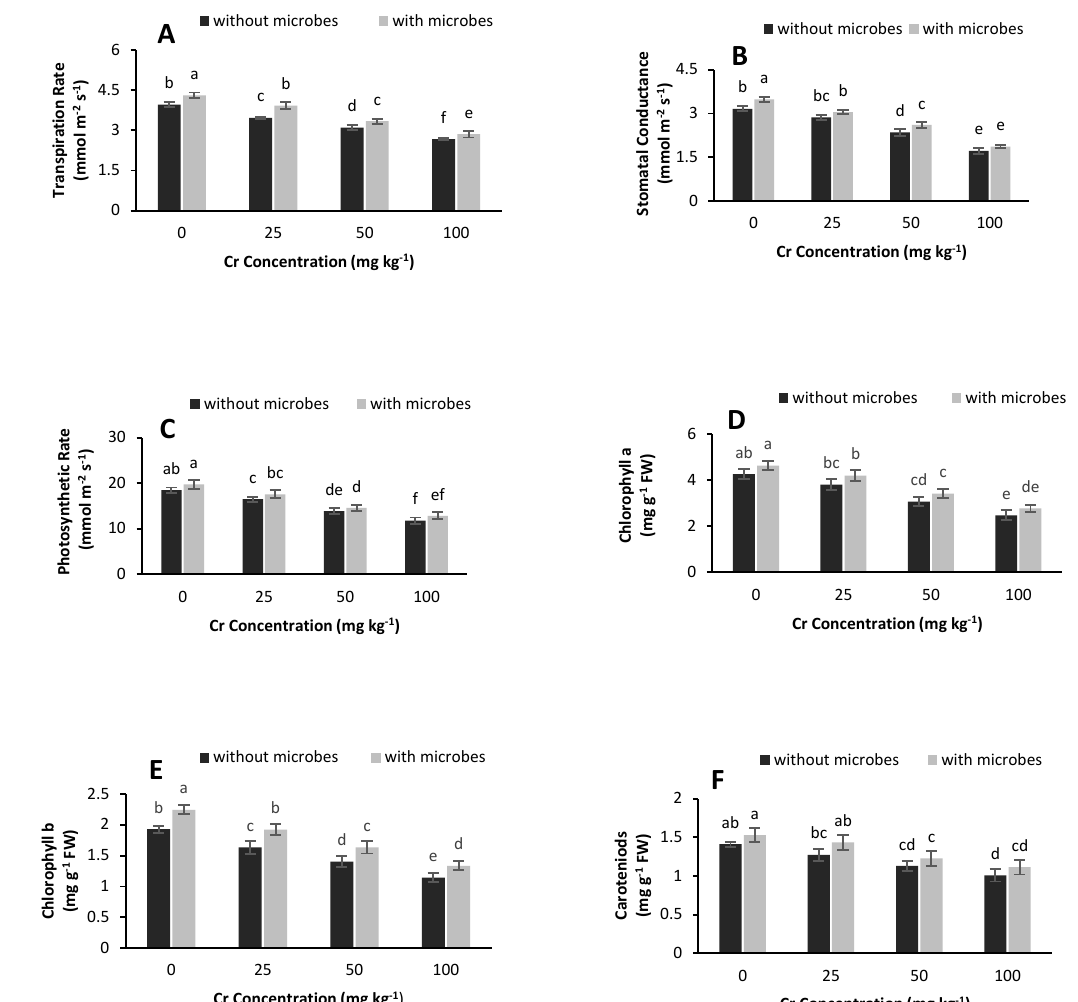
Figure 3. Influence of the di ff erent Cr levels (0, 25, 50, 100 mg · kg − 1 ), with and without peat-moss-based microbial inoculation, on transpiration rate ( A ), stomatal conductance ( B ), photosynthetic rate ( C ), chlorophyll a ( D ), chlorophyll b ( E ) and carotenoids ( F ) of wheat plants. Bars indicate the mean values and standard deviation of three replicates. Di ff erent bar letters show significant changes among various treatments at p < 0.05.